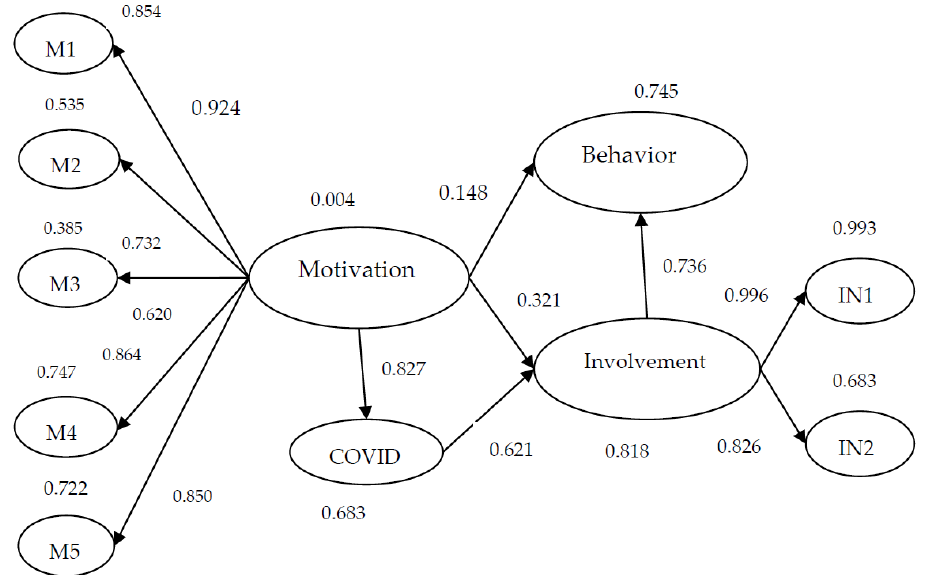
Figure 2. Result of the structural equation model.